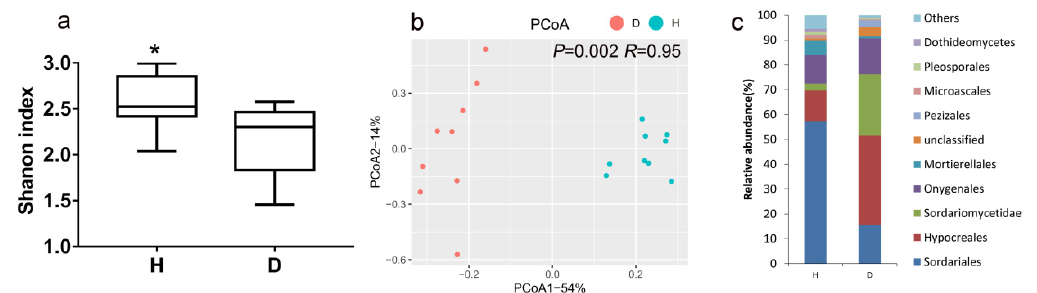
Figure 2. Fungal community diversity, structure and composition in healthy (H) and bacterial wilt-diseased (D) tomato plant rhizospheres. ( a ) Fungal community Shannon diversity of rhizosphere soils between healthy (H) and bacterial wilt-diseased (D) tomato plant rhizospheres. Statistical significance was determined based on Student’s t -test. * p < 0.05. ( b ) Principal coordinate analysis (PCoA) based on Bray–Curtis index dissimilarity of relative abundance data in healthy (H) and bacterial wilt-diseased (D) tomato plant rhizosphere fungal communities. ( c ) Relative abundance (%) of the orders in the rhizospheres of healthy (H) and bacterial wilt-diseased (D) tomato plants.